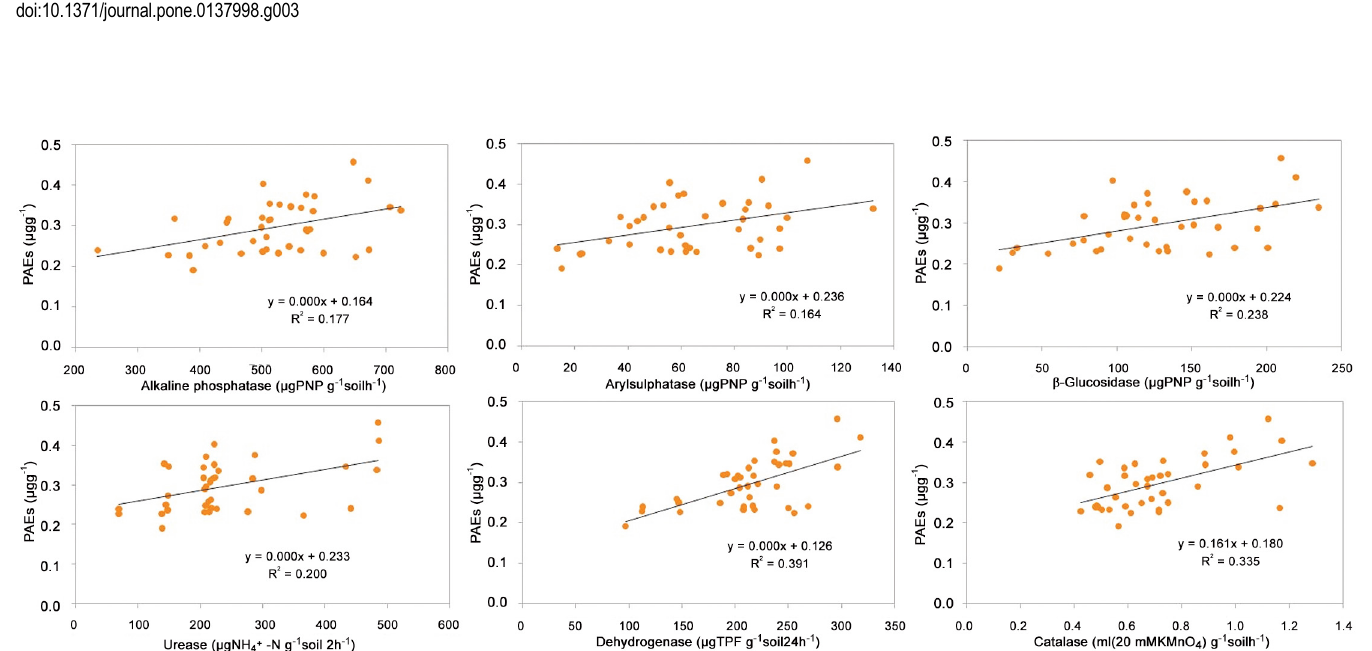
Fig 4. Correlations of PAEs concentrations with the soil enzyme activities in the agricultural soils along the WYR.